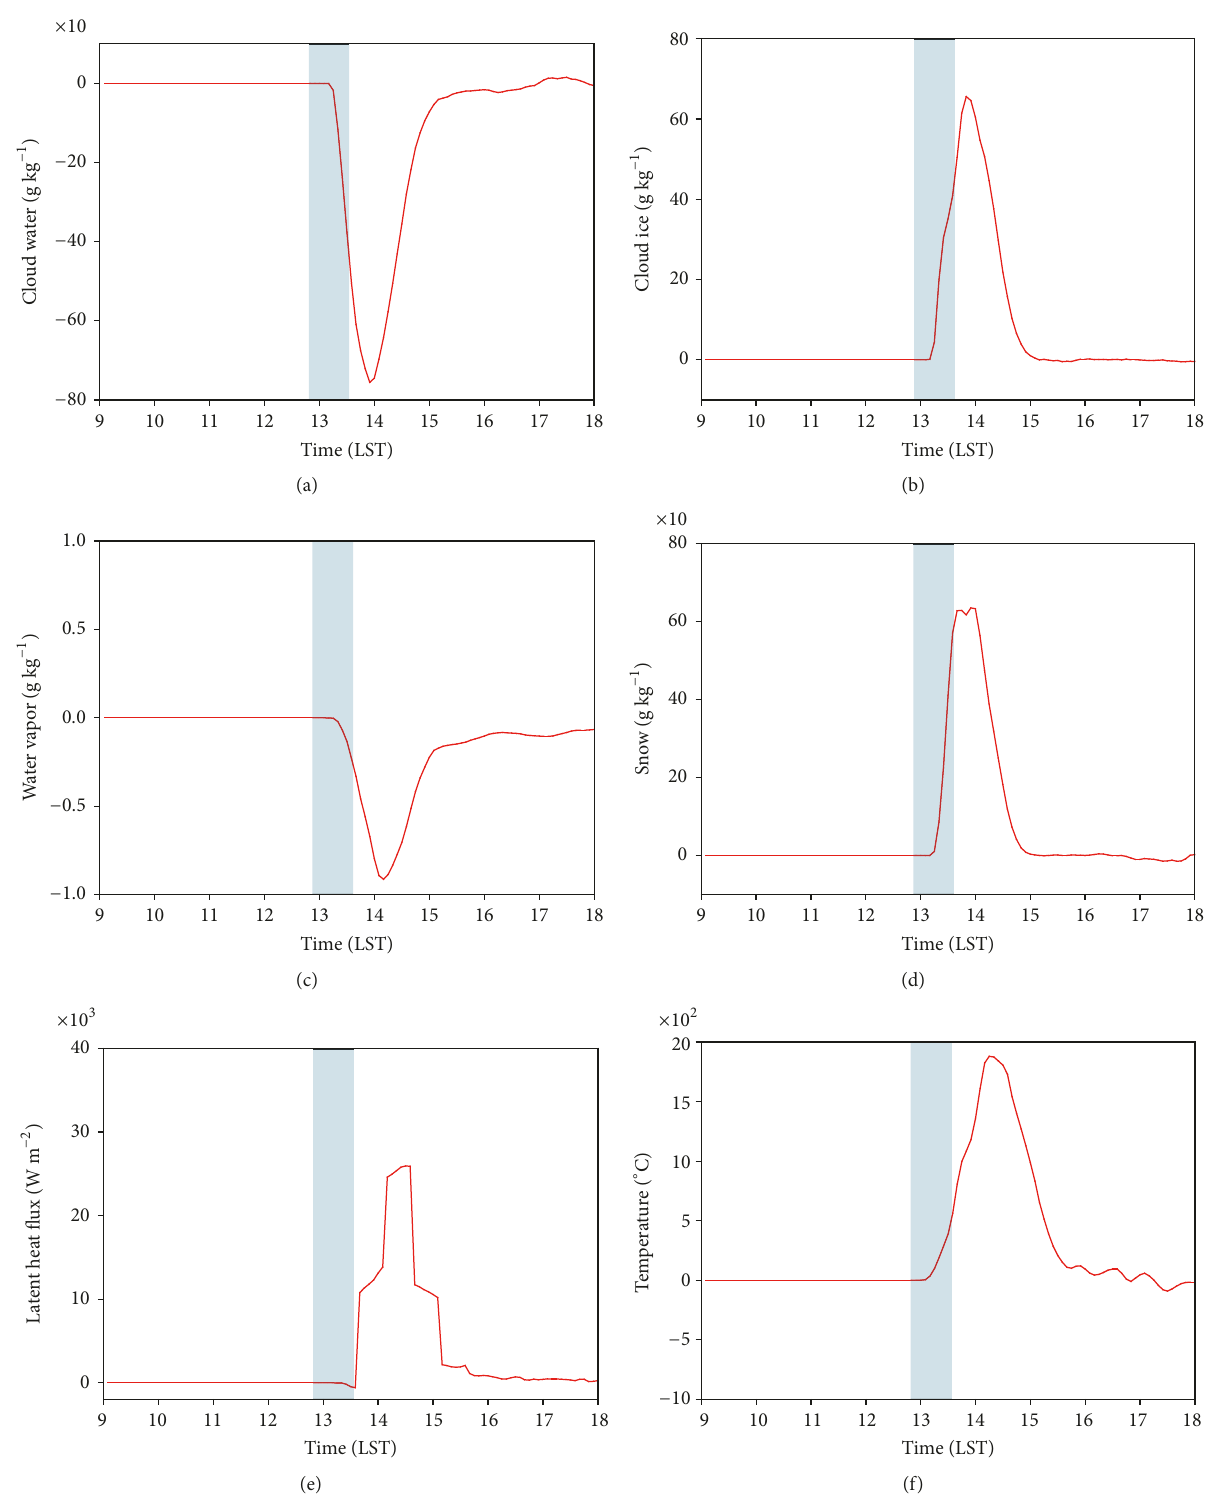
Figure 7: Time series of the total amount difference (SEED − NOSEED) of (a) the cloud water mixing ratio, (b) cloud ice mixing ratio, (c) water vapor mixing ratio, (d) snow mixing ratios, (e) latent heat flux, and (f) temperature, which are horizontally and vertically integrated in the verification zone (the box area in Figure 6(b)) for EXP1. The seeding period is shaded in light